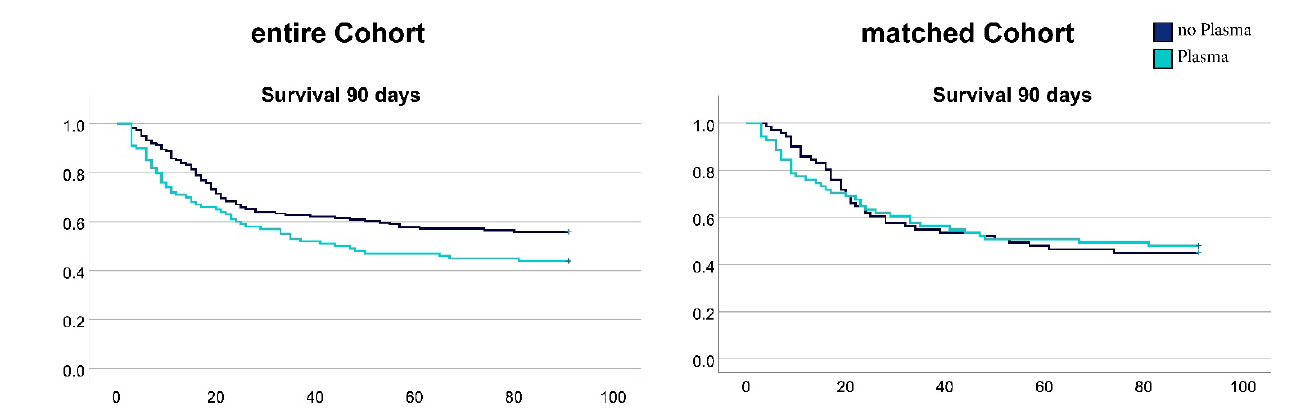
Figure 3. Ninety-day survival plots for the unmatched and the matched cohort. Plots show the relative survival of patients in the plasma group (cyan) and the control group (dark blue) over time. Log-rank test was used for statistical analysis.